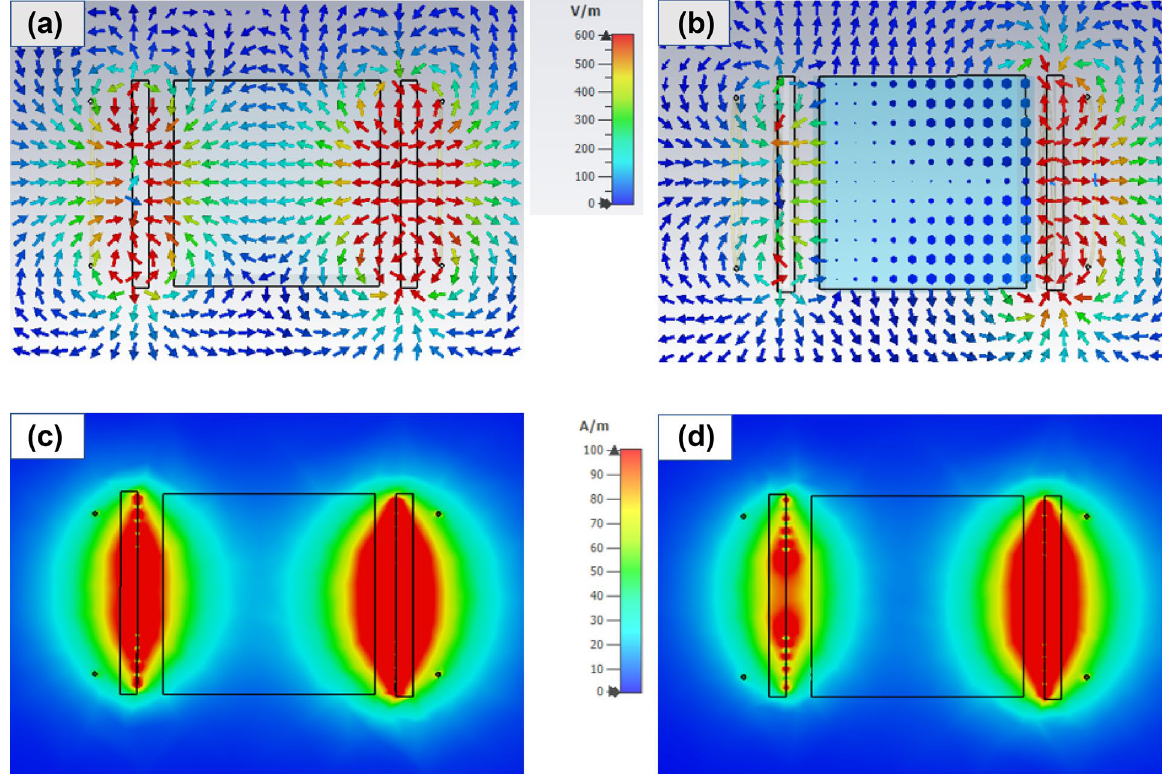
Figure 2. Field intensity distribution of (a) E-field in free space, (b) E-field with a conducting block, (c) H-field in free space, (d) H-field with a conducting block.